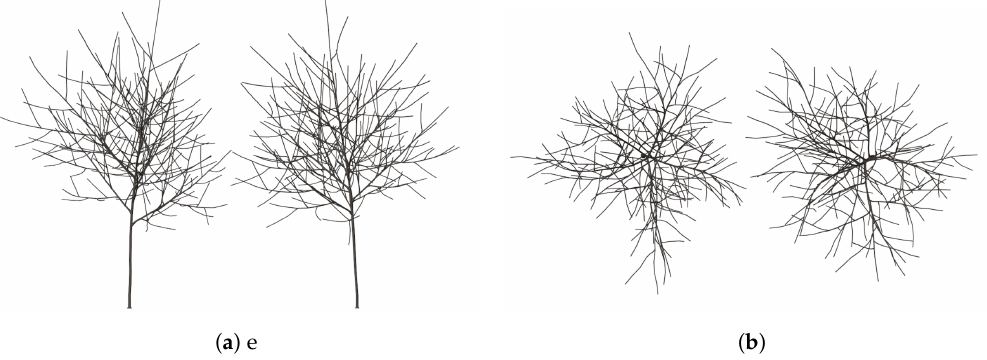
Figure 14. Group of 2 trees growing at 1 m distance. ( a ) Side view of 2 trees growing at 1 m distance; ( b ) Top view of 2 trees growing at 1m distance.